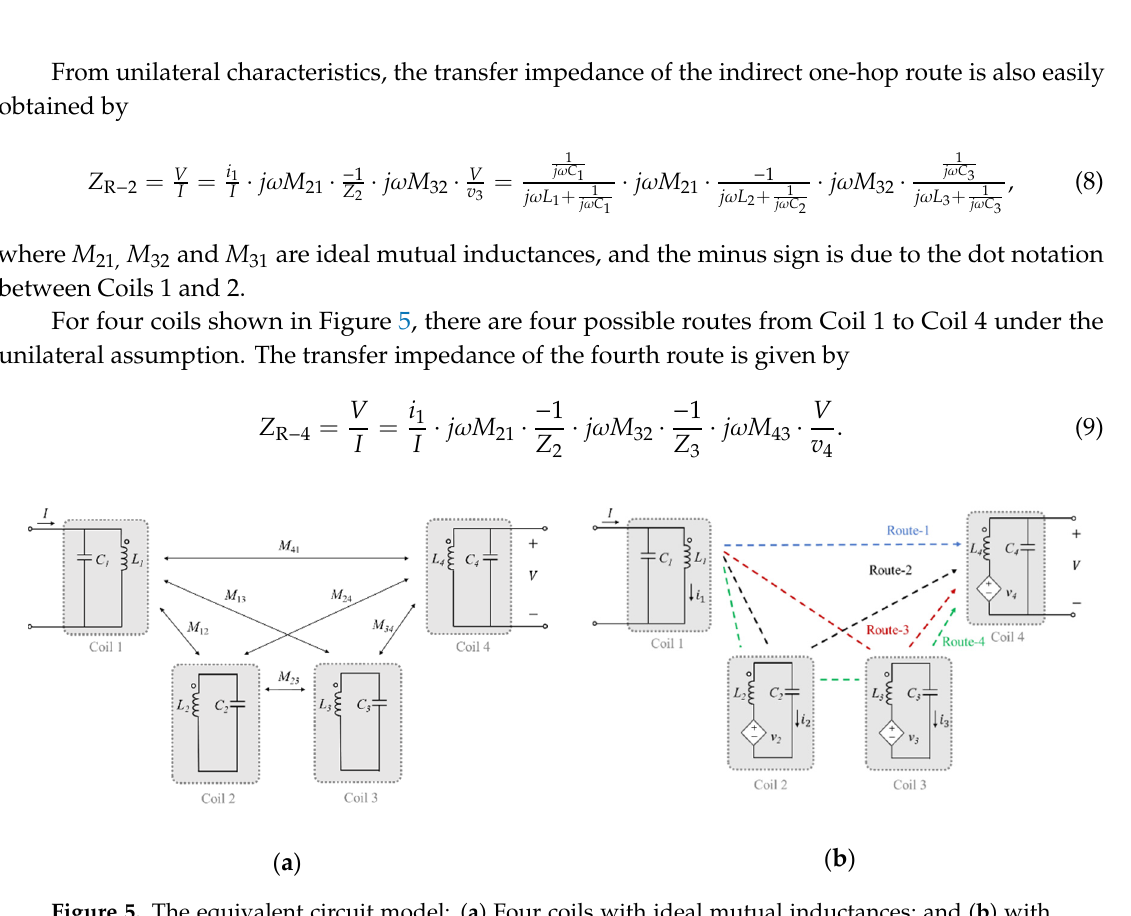
Figure 4. The equivalent circuit model: ( a ) Three coils with ideal mutual inductances; and ( b ) with two routes.